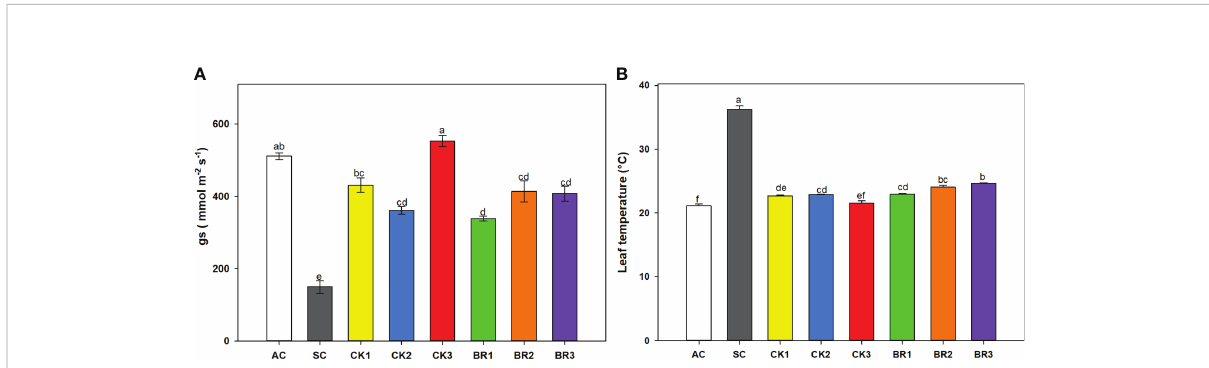
FIGURE 1 Effect of the number of applications of two growth regulators (cytokinins (CK) or brassinosteroids (BR)) on stomatal conductance (g s ) (A) and leaf temperature (B) in rice plants of genotype Fedearroz 2000 subjected to combined heat stress (40°C day/30°C night) at 55 days after emergence (DAE). The treatments evaluated were as follows: absolute control (AC), heat stress control (SC), one foliar spray of CK (CK1), two foliar sprays of CK (CK2), three foliar sprays of CK (CK3), one spray foliar spray of BR (BR1), two foliar sprays of BR (BR2) or three foliar sprays of BR (BR3). Each column represents the mean of fi ve data ± standard error (n = 5). Bars followed by different letters indicate statistically signi fi cant differences according to Tukey ’ s test (P ≤ 0.05). Equal letters indicate that the means are not statistically signi fi cant ( ≤